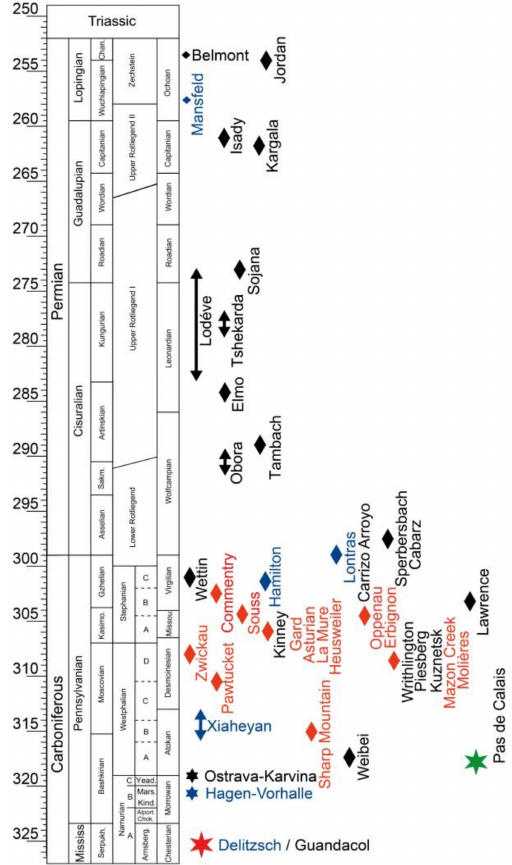
Figure 1. Stratigraphy of the oldest known winged insects (red star), oldest known blattoid in- sects (green star), and important Late Paleozoic entomofaunas. Localities in blue indicate ma- rine insect deposits; names in red mark the localities with gyroblattids (see Table 1). Abbrevia- tions: Mississ.—Mississippian; Serpukh.—Serpukhovian; Kasimo.—Kasimovian; Sakm.—Sakmarian; Chan.—Changhsingian; Arnsberg.—Arnsbergian; Chok.—Chokerian; Alport.—Alportian; Kind.— Kinderscoutian; Mars.—Marsdenian; Yead.—Yeadonian;